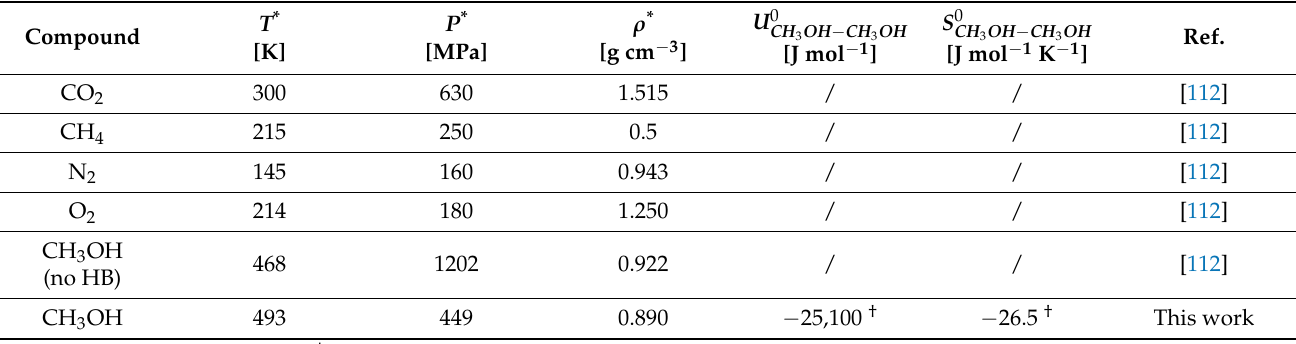
Table 5. List of input parameters.